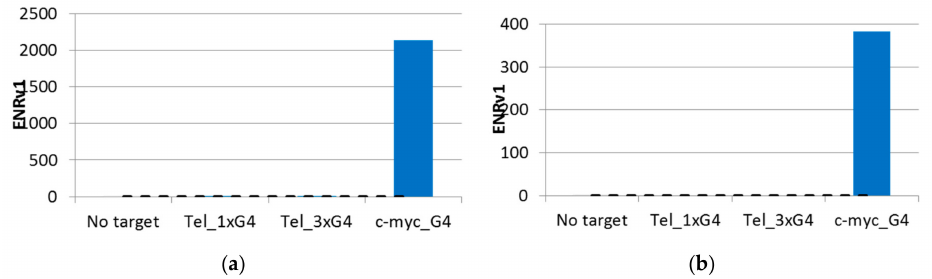
Figure 3. Profiles indicating the relative enrichments of specific compounds across di ff erent selections: ( a ) Compound 1 ; ( b ) Compound 2 . These compounds were enriched only against the c-myc G4 target and were not enriched against the o ff -targets or the no-target control. The y axis represents a metric of enrichment significance (ENRv1) for each disynthon (negative log 10 of the asymptotic significance value).